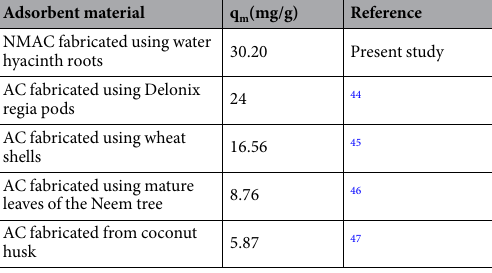
Table 2. Comparable investigation for mono-layer adsorption capacity of prepared NMAC with various fabricated AC